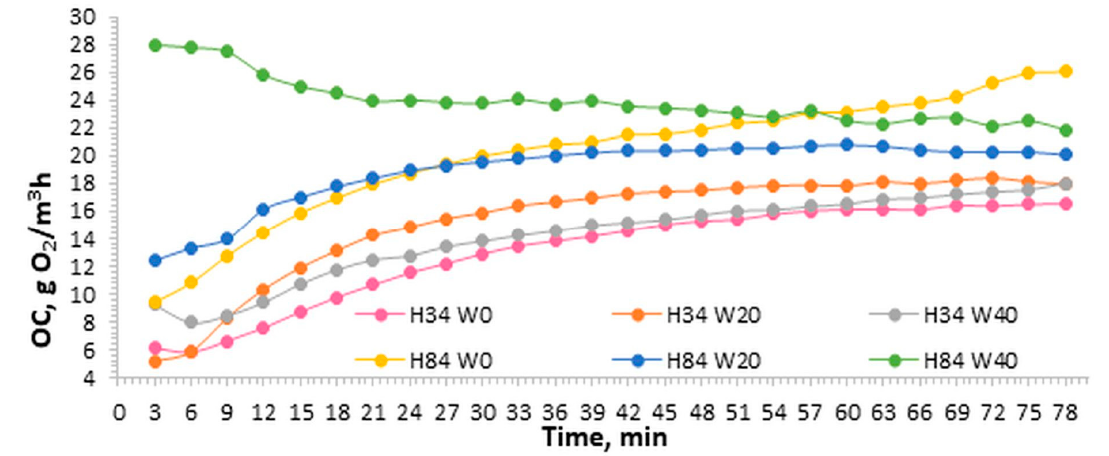
Figure 11. Oxygenation capacity of a barbotage reactor depending on aeration time for different structural design and reactor filling variants.